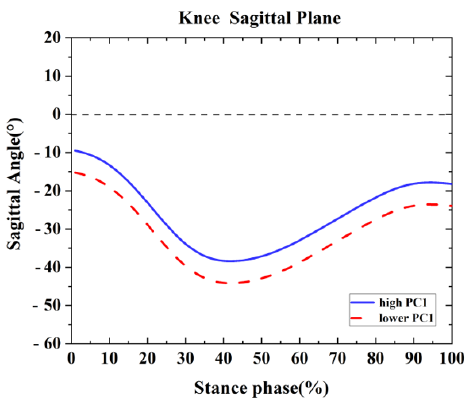
Figure 5. Principal components are retained for the knee. The waveform differences between competitive runners and recreational runners of reconstruction principal using the high and lower PC1-scores in the ankle sagittal plane.